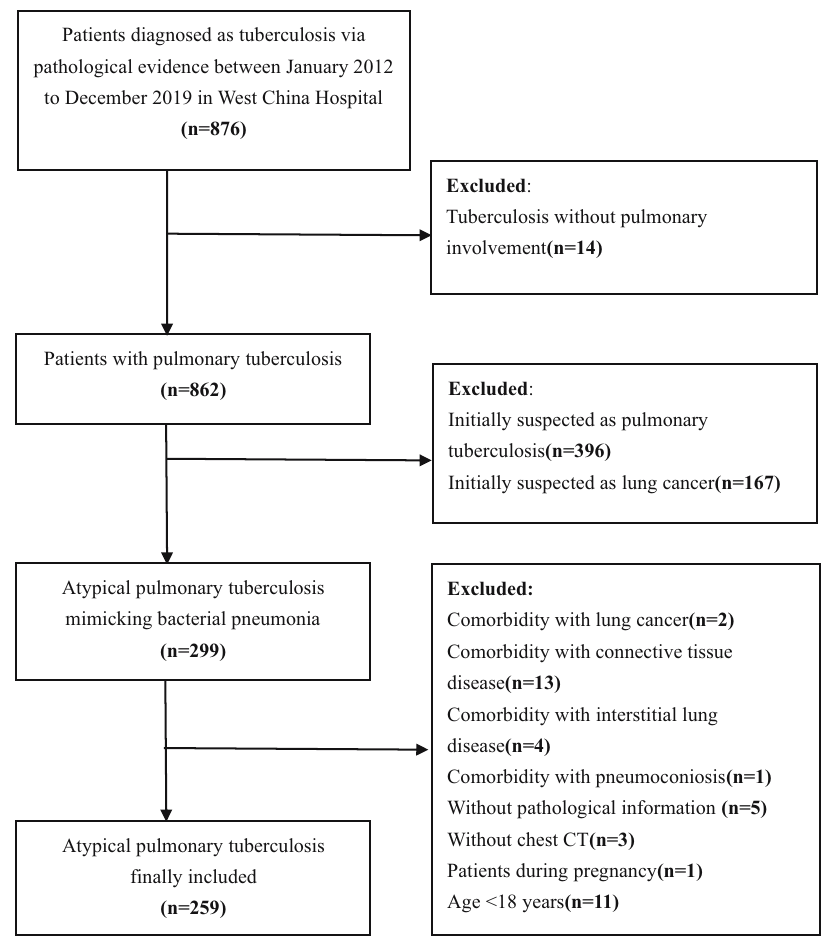
Figure 1: The fl owchart of patients ’ enrollment. There were 876 patients diagnosed as tuberculosis pathologically, and after excluding those patients who did not meet the criteria, 259 patients were enrolled